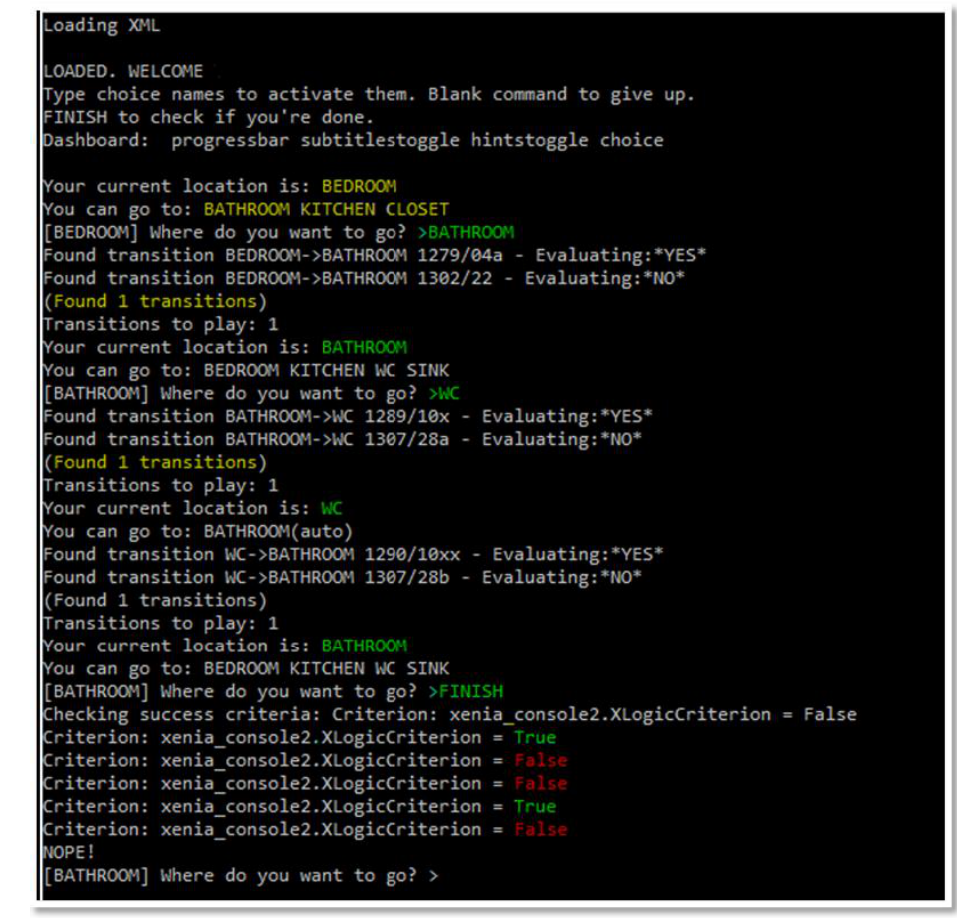
Figure 30. Game logic: two of the five criteria are met. There are two restrictions. According to hygiene rules, every time students choose the button “WC” they must then choose the button “HANDS”, otherwise, the avatar is not allowed to eat. The second restriction which is also derived from the hygiene rules is that after eating students have to brush their teeth. The condition for “game over-well done” is that the students have guided the avatar to WC, to wash her hands (HANDS), to eat (FOOD), to brush her teeth (TEETH), and to put on her clothes (CLOSET). Figure 31 illustrates that all five criteria are met and so students have completed all the activities that need to be performed at home before leaving school.